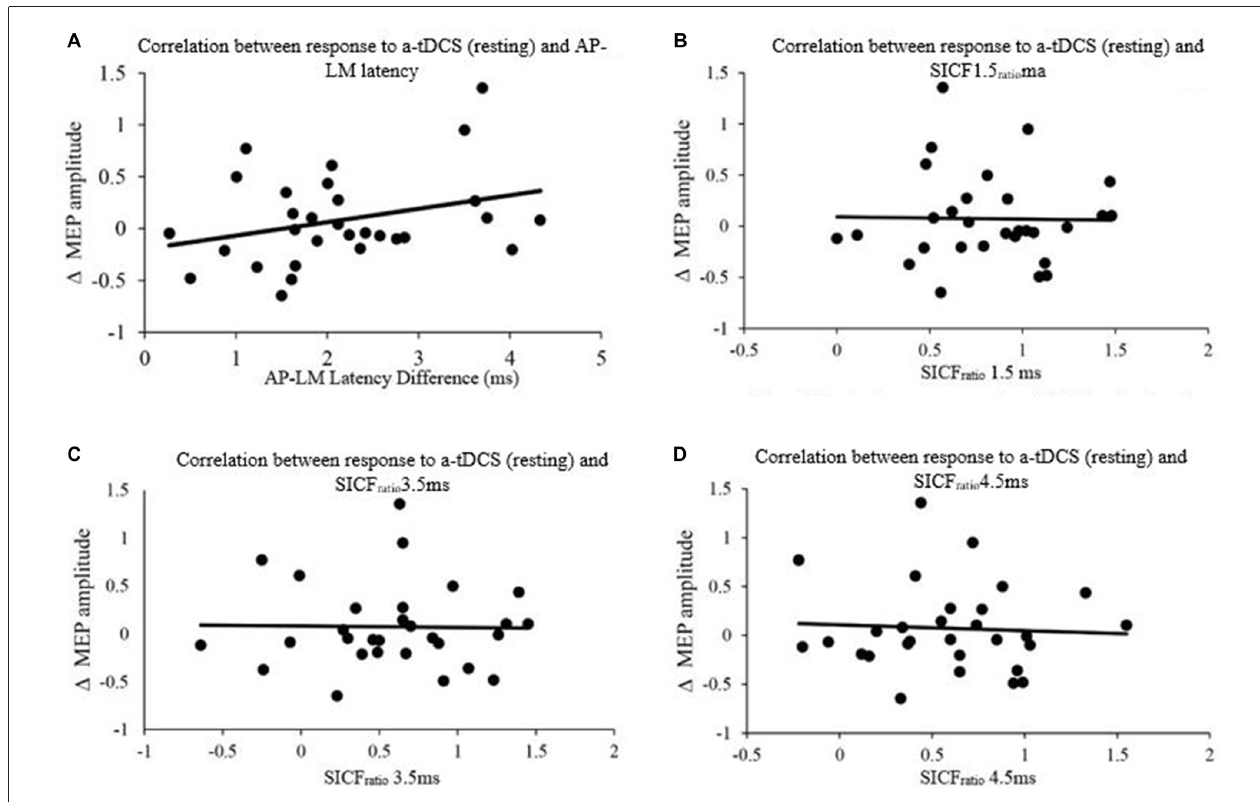
FIGURE 5 | Correlation between response to Anodal-tDCS (a-tDCS; resting) and (A) AP-LM latency, (B) SICF ratio 1.5 ms, (C) SICF ratio 3.5 ms and (D) SICF ratio 4.5